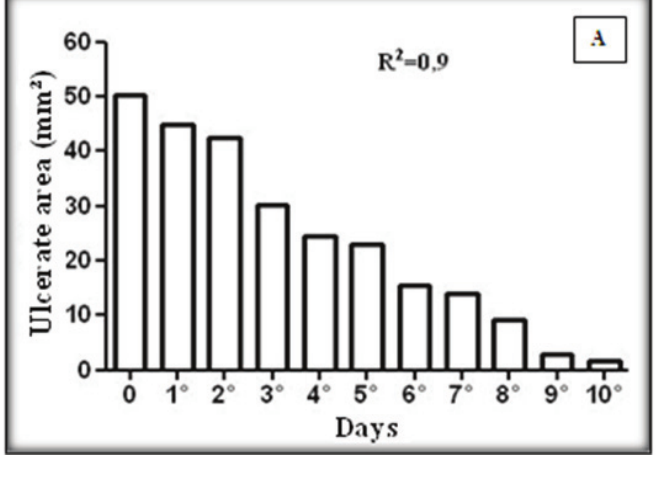
FIGURE 6 – ( A ) Photomicrograph of histological sections of the cheek mucosa of rats (1st and 2nd days after ulceration) showing the presence of vessels and ulcer (black arrow) associated with intense mixed leukocytic inflammatory infiltrate (HE, 200X). ( B ) Photomicrograph of histological sections of the cheek mucosa of rats (1st and 2nd days after ulceration) showing the mixed leukocytic inflammatory infiltrate (HE, 400X). ( C ) Photomicrograph of histological sections of the cheek mucosa of rats (3rd and 4th days after ulceration) with the presence of lymphoplasmacytic inflammatory infiltrate and some neoformed capillaries (white arrow) (HE,